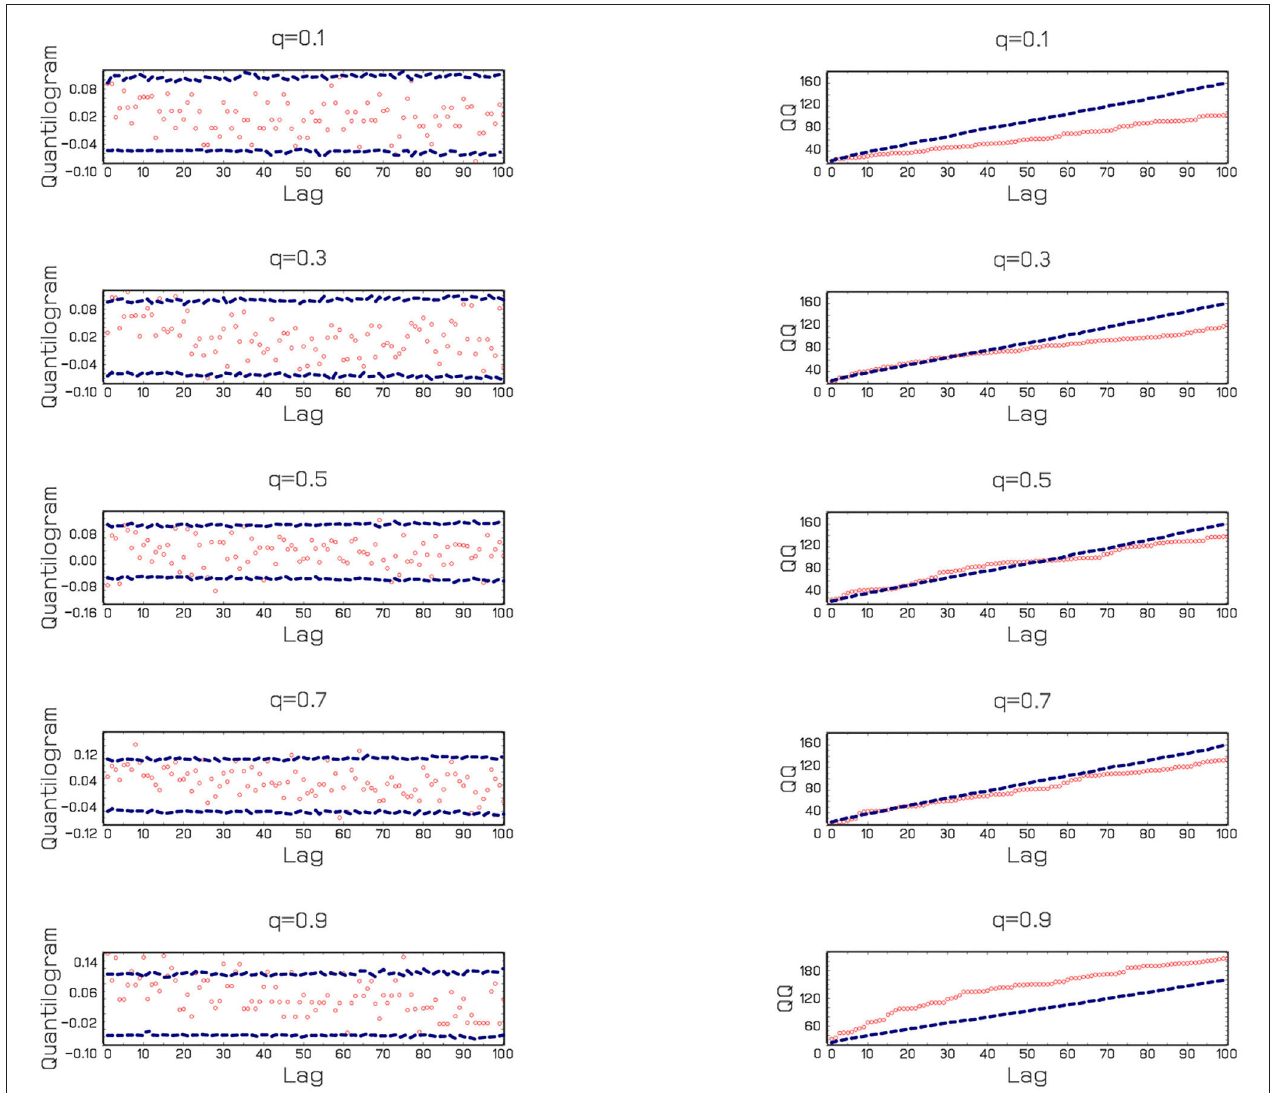
FIGURE 1 | Results of the Q–Q Estimations of Sim and Zhou (64).